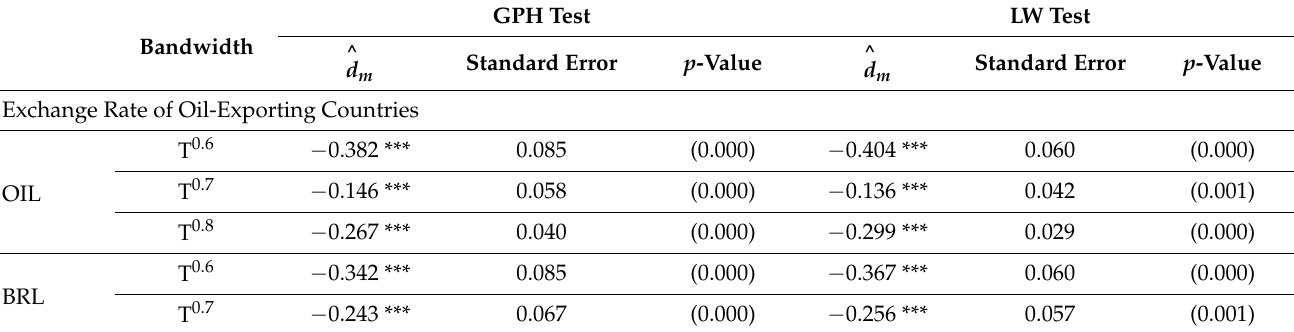
Table 2. GPH and LW tests for